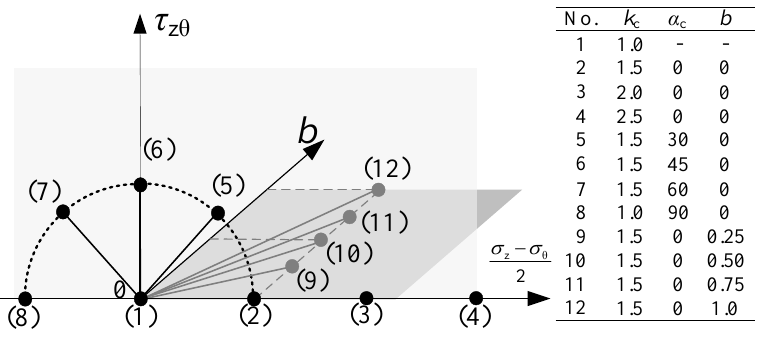
Figure 3. Consolidation stress